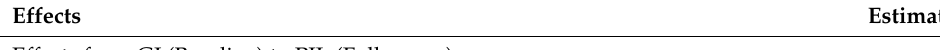
Table 4. Coefficients for total, total indirect, and specific indirect effects of the path model.